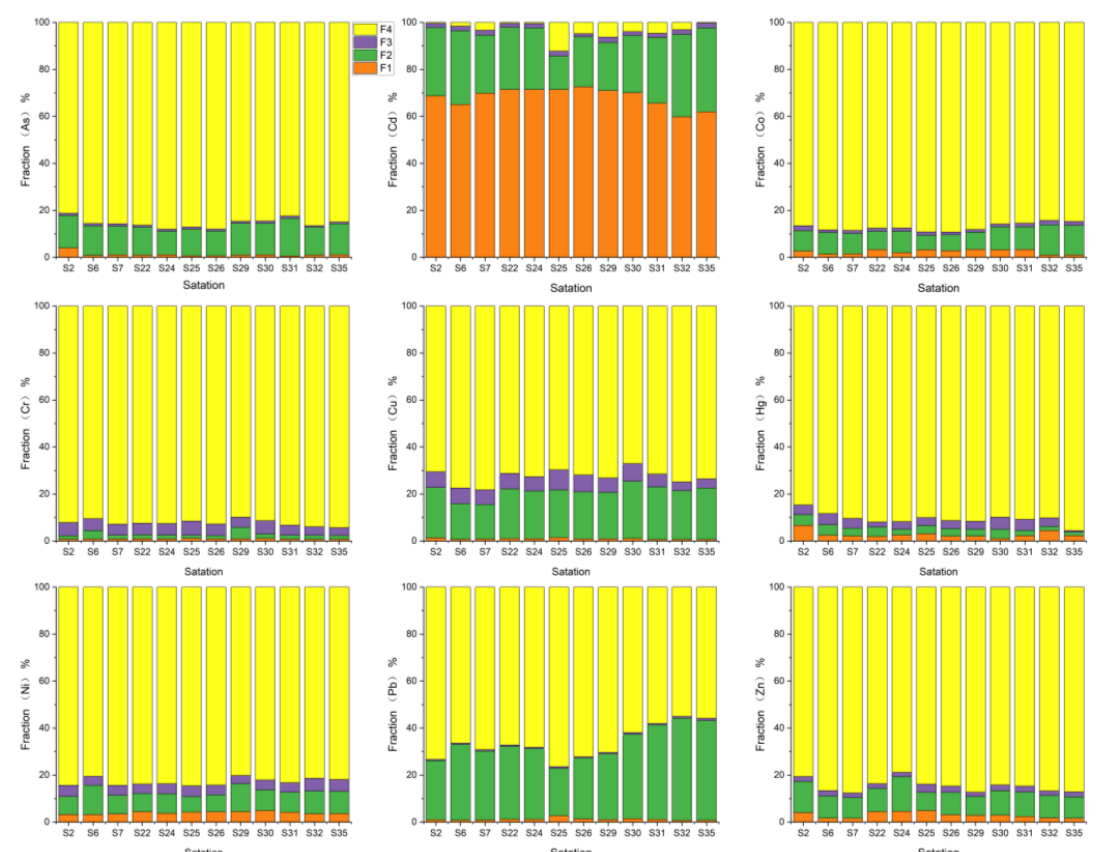
Figure 3. Percentage distribution of heavy metals: the exchangeable fraction (F1), the reducible fraction (F2), the oxidizable fraction (F3), and residual fraction (F4) at 19 stations.